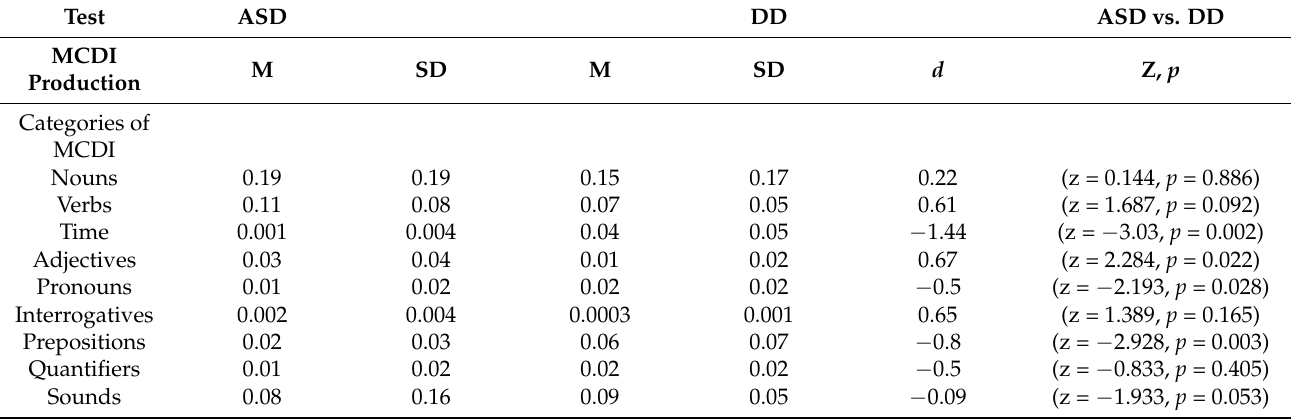
Table 6. Descriptive statistics corresponding to the proportions for each category of MCDI with respect to lexical production.